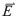
Electric field coupling with wire.Coupling of the electric field (E⇀) with the wire (shown in grey). Charge distribution is represented by “+”. (a) The tangential component of E⇀, E
t, induces a current (I) along the wire. (b) The current produces a charge build-up at the tip of the wire creating a concentrated electric field (E⇀final), and enhancing the overall power deposition at the tip of the wire according to Ohm’s law.